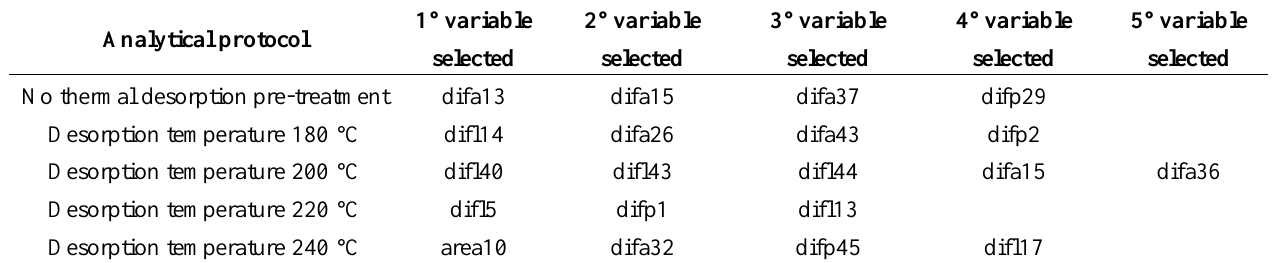
Table 3. Variables selected by the CART